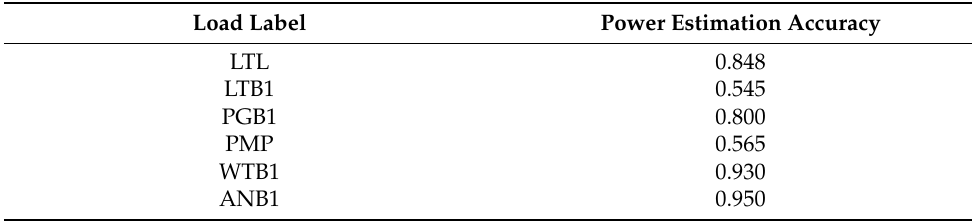
Table 9. Power demand estimation accuracy associated with the MTR model.